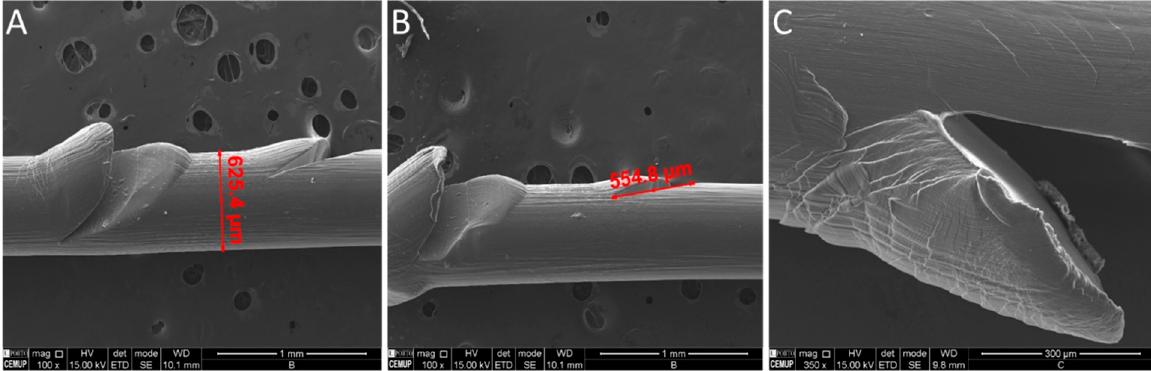
Figure 4. PCL cog thread SEM images: ( A ) Thread diameter dimension (mag.—100×, scale—1 mm); ( B ) Cog cutting dimension (mag.—100×, scale—1 mm); ( C ) Cog image (mag.—350×, scale—300 µm). Force-strain curves (Figure 5) represent the nonlinear mechanical behavior of PCL cog threads during uniaxial tensile testing. Threads could sustain 17–18 N at 18%–22% of deformation.